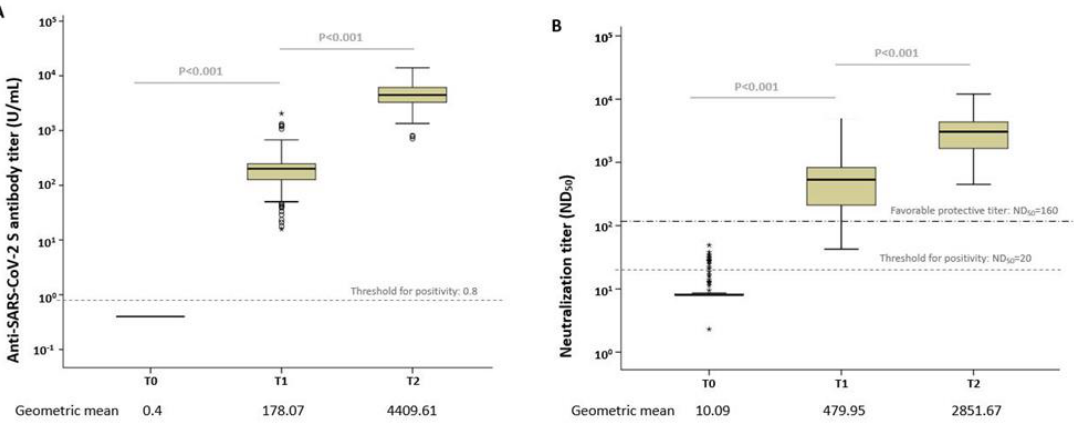
Figure 2. Box plots of the anti-SARS-CoV-2 antibody levels. ( A ) Anti-S IgG antibody and ( B ) median neutralizing titer (ND50) at each time point. The dotted line shows the threshold for positivity. Open circles depict outliers. Extreme values marked with a star.